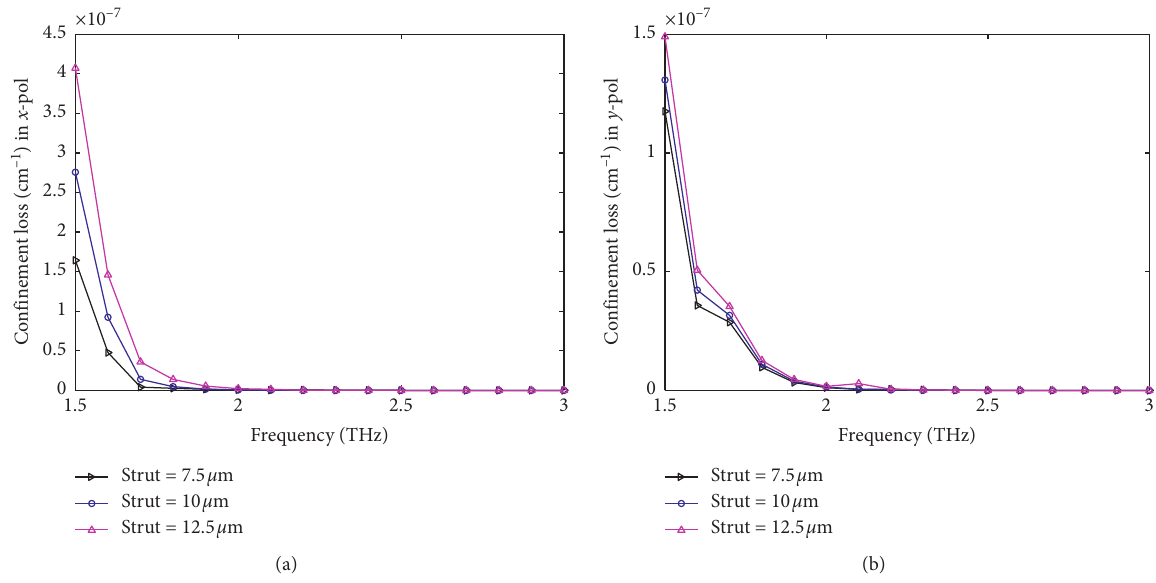
Figure 13: The fluctuation of the CL in the THz band for the three strut values. (a) x -PoM and (b) y -PoM.